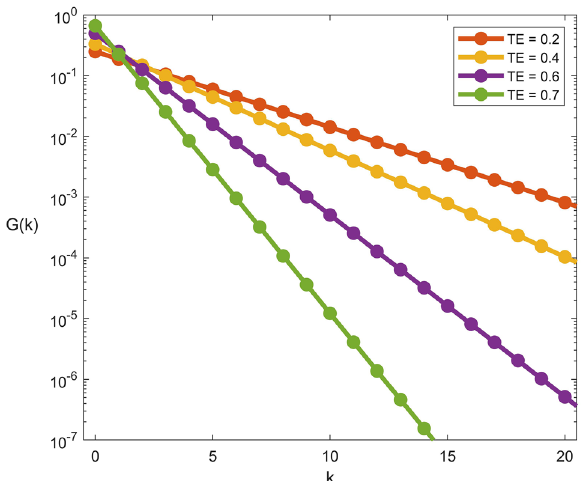
Figure 5. Probability distribution of relapses. k represents the number of times that a patient has experienced treatment failures or relapses. Different treatment efficacies ( TE ) are shown by different colours.